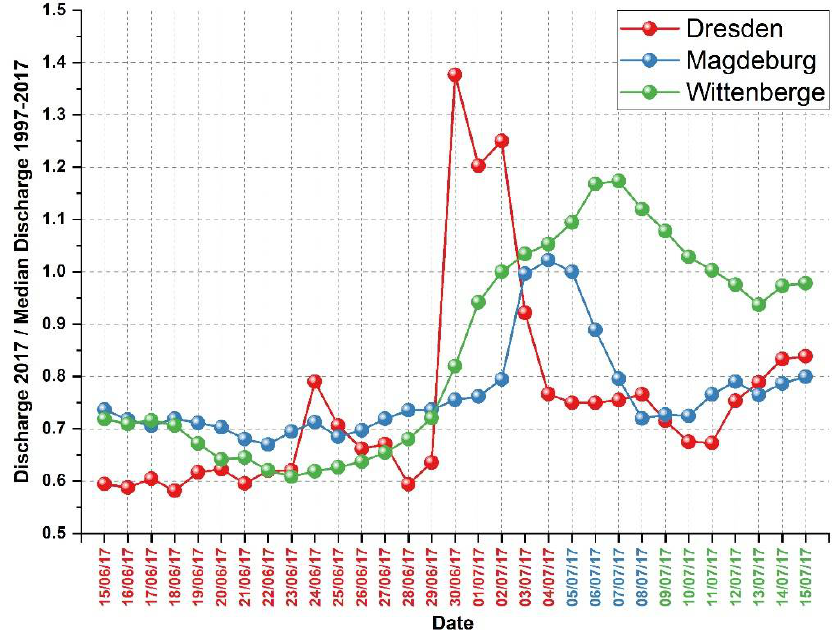
Figure 3. Normalized daily mean discharge at the monitoring stations Dresden, Magdeburg and Wittenberge from 15 June to 15 July 2017 (Discharge 2017). The respective median of the daily mean discharge between 1997 and 2017 (Median Discharge 1997–2017) was used to normalize the mean discharge rates of each day. The data were acquired from the Elbe Data Information System (FIS) [24] of the River Basin Community Elbe (FGG Elbe). The different colors of the date indicate the monitoring station that was most recently passed by the research vessel.